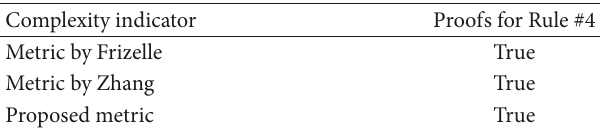
Table 11: Proofs of Rule #4. Table 12: Sequence of operations for 19